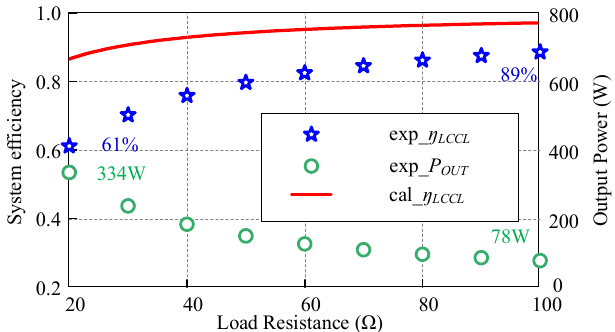
Figure 18. Measured efficiency and output power.